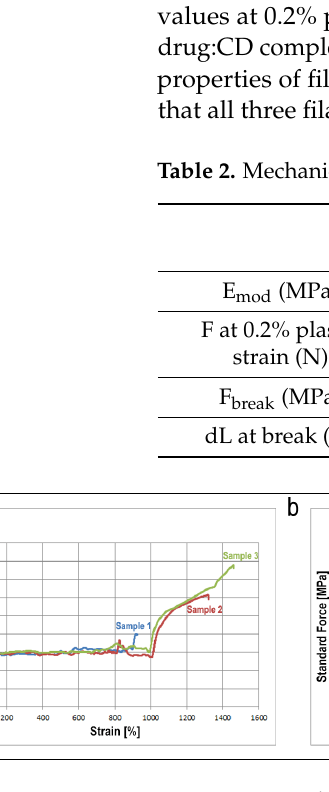
Figure 6. DSC thermogram of ( a ) PCL pellet, ( b ) Blank PCL Filament, ( c – e ) PCX:CD PCL Filament, ( d – f ) CBP:CD PCL Filament, and FTIR spectrums of ( g ) PCX:CD PCL Filament and ( h ) CBP:CD PCL Filament.